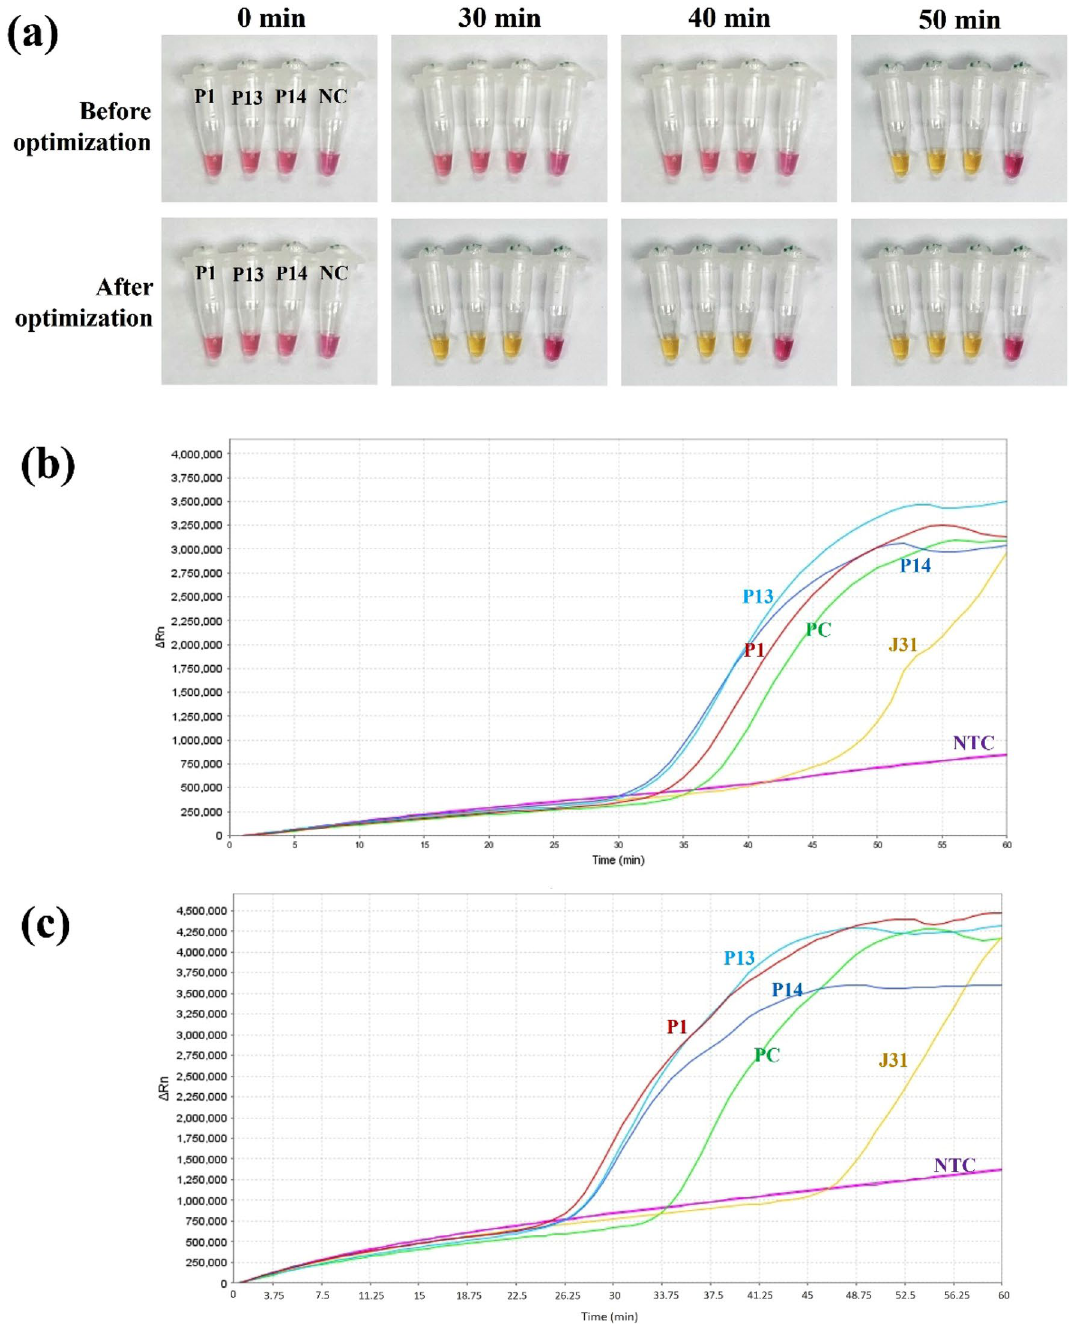
Figure 2. ( a ) Colorimetric RT-LAMP using E-ID1 primer set on clinical samples before and after optimization. The optimized colorimetric assay started to detect the positive samples within 30 min compared to 50 min before optimization. ( b ) Fluorometric RT-LAMP before (cycle number on the x-axis also corresponds to reaction time, in minutes, since the reaction set up here was 60 cycles of 1 min) and ( c ) after optimization using LavaLAMP reagents (Lucigen, Middleton, WI, USA) on different clinical samples, where the improvement in the detection time can be